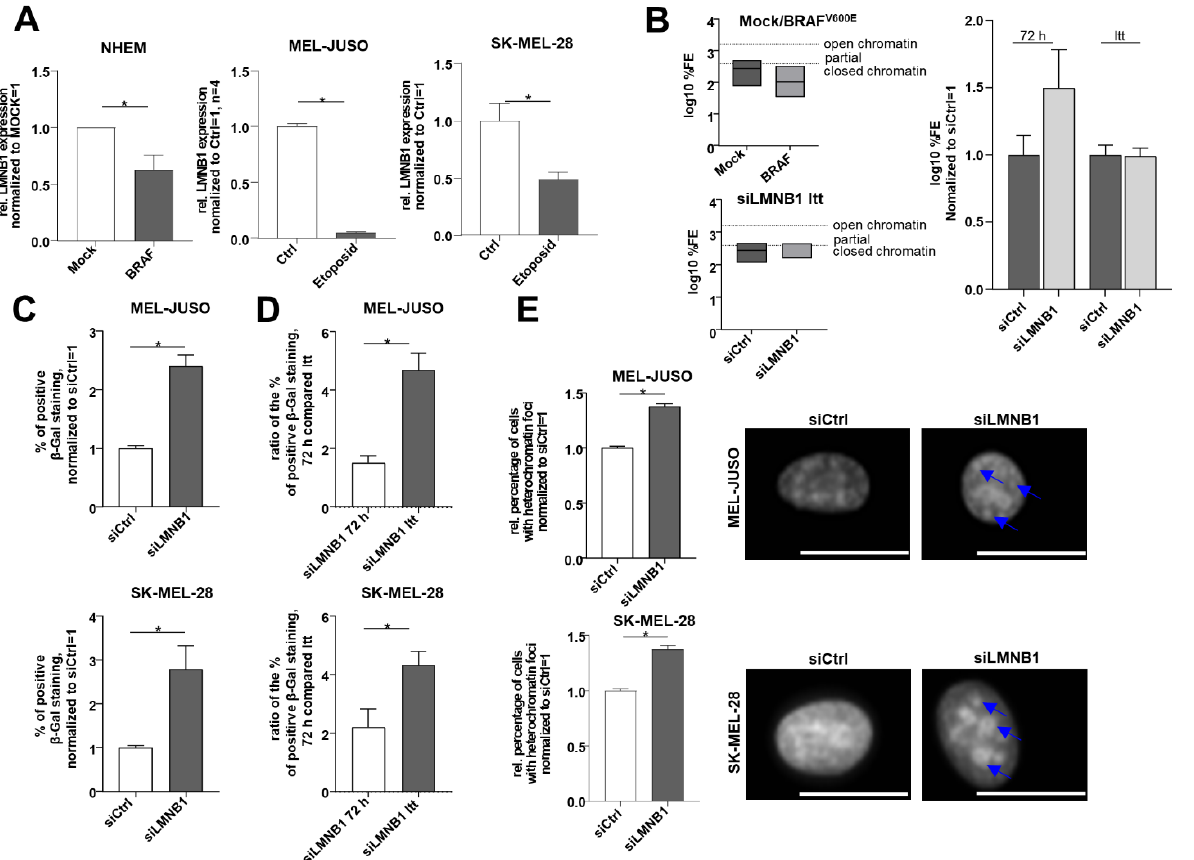
Figure 3. ( A ) LMNB1 expression analysed by qRT-PCR in the established senescence model using mock- and BRAF V600E lentiviral-transduced NHEMs, as well as MEL-JUSO and SK-MEL-28 cells treated with the cytostatic drug etoposide compared to the control (Student’s t -test). ( B ) Epiquik Chromatin Accessibility Assay to verify the chromatin status in NHEM, lentiviral-transduced with Mock as control and BRAF V600E (established senescence model) and siLMNB1-long-term-treated melanoma cells (MEL-JUSO) compared to siCtrl. Normalized log10 %FE for siCtrl 72 h and siCtrl LTT was used to exclude an effect of the transfection process by siCtrl over a longer period. ( C ) SA β -Gal staining of MEL-JUSO and SK-MEL-28 long-term-transfected with siLMNB1 and siCtrl as se- nescence detection (Student’s t -test). ( D ) Ratio in % of positive S β -Gal staining of MEL-JUSO and SK-MEL-28 for transfection with siLMNB1 72 h in comparison to long-term transfection. The per- centage of beta-gal-positive stained melanoma cells of the respective siCtrl was included in the ratio between siLMNB1 72 h and siLMNB1 LTT (Student’s t -test). ( E ) The melanoma cell lines MEL-JUSO and SK-MEL-28 were long-term-transfected for three months with siLMNB1 and siCtrl, respec- tively. Chromatin condensation was analyzed using DAPI staining and subsequently quantified. Enlarged images show representative chromatin foci marked with blue arrows. Scale bars equal 20 µm. Bars represent the means ± SEM (* = p ≤ 0.05). 3.4. Predicted Role of LMNB1 in Melanoma Based on Transcriptome Analyses To further determine the molecular role of LMNB1 in melanoma and its involvement in relevant biological processes in cancer, RNA-Seq of siLMNB1-transfected primary mel- anoma cell lines (MEL-JUSO) was performed (PRJNA841450). Before RNA-Seq library preparation, the transfection efficiency was confirmed via qRT-PCR (Figure S3B). The data obtained from the RNA sequencing approach were pre-processed, quality-checked (FastQC v0.11.9) [25] and mapped to the human genome (GRCh38.p5, release 24) (STAR v2.7.9a) [26]. Next, a count table was generated via featureCounts (v2.0.1) [27] and used for differential gene expression analysis by the DeSeq2 package [29] in R (v4.0.5, The R Foundation for Statistical Computing) [28]. Differential gene expression analysis resulted in 66 significantly upregulated and 66 significantly downregulated genes in siLMNB1-